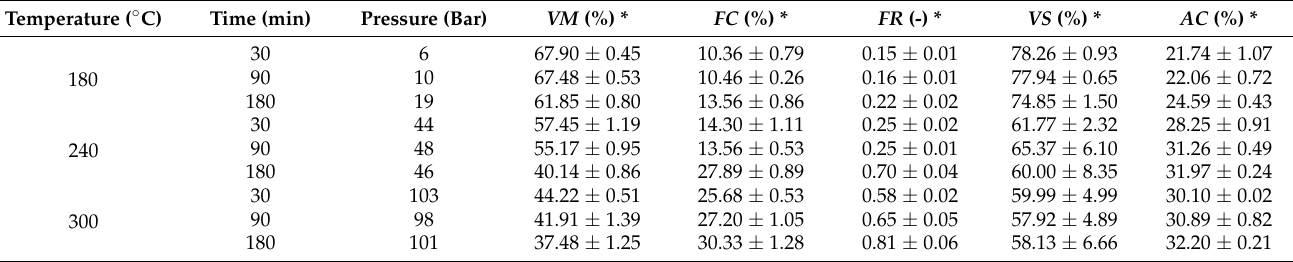
Table 2. Proximate analysis and reached pressure of derived